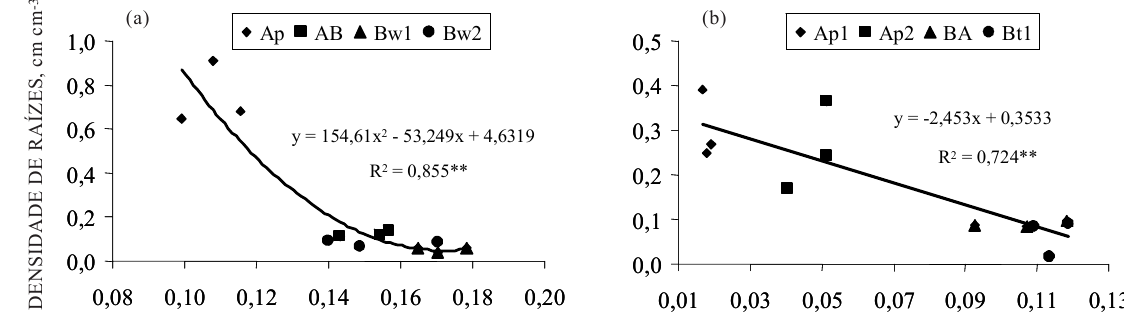
Figura 9. Relação entre densidade de raízes de citros e umidade crítica de resistência à penetração (UCRP), em Latossolo Amarelo (a) e Argissolo Acinzentado (b) de Tabuleiros Costeiros da Bahia, na avaliação de indicadores de horizontes